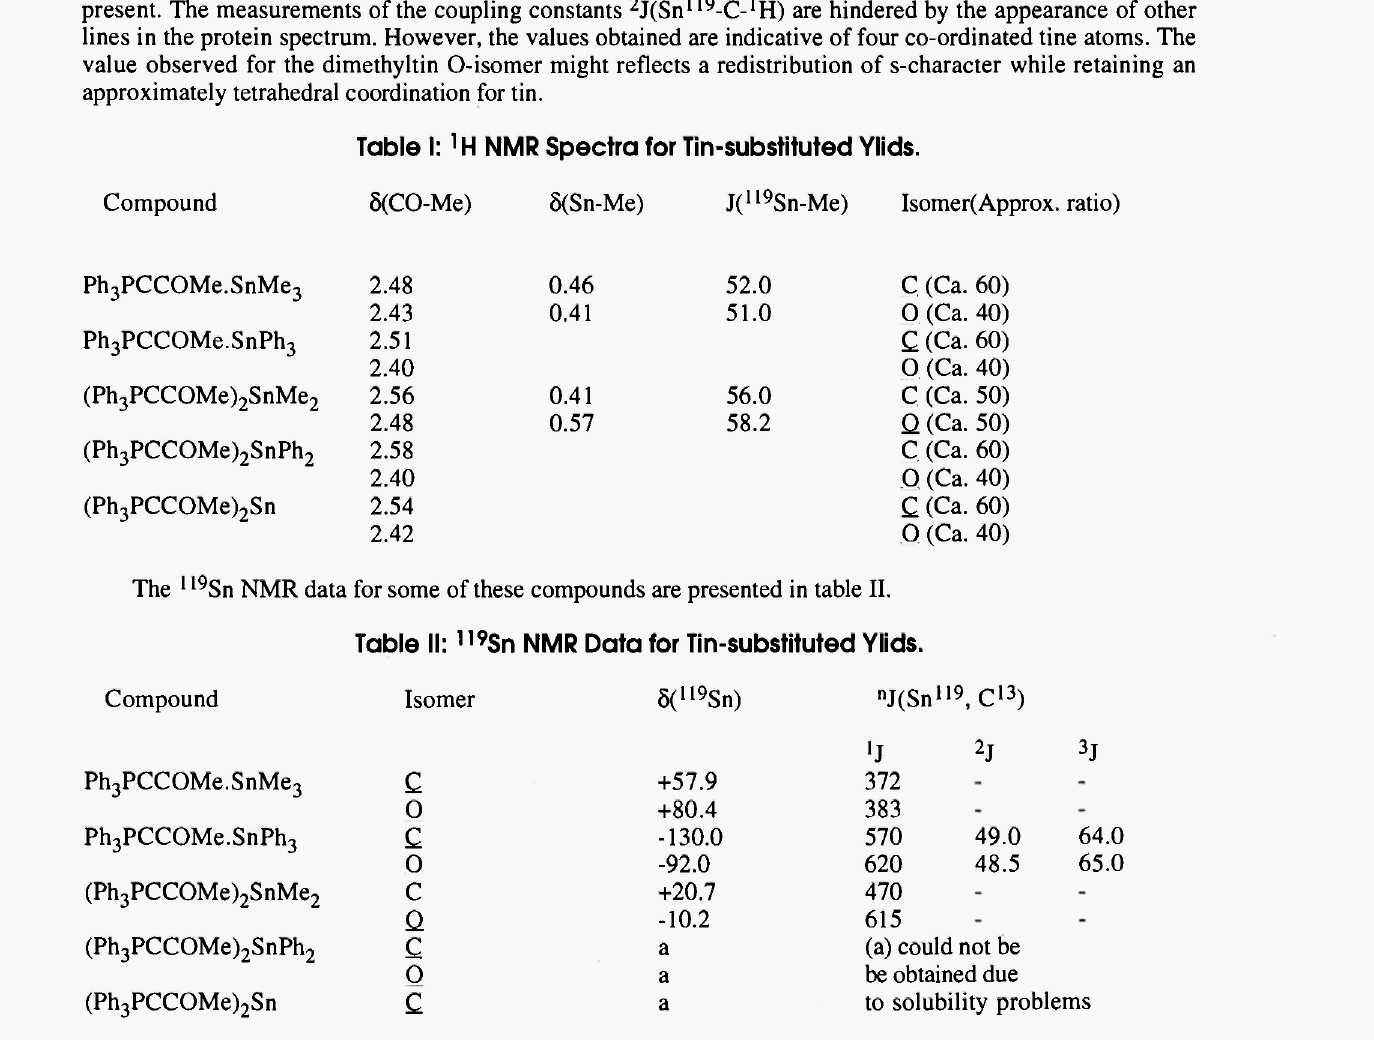
Table 1: 1 Η NMR Spectra for Tin-substituted Ylids.